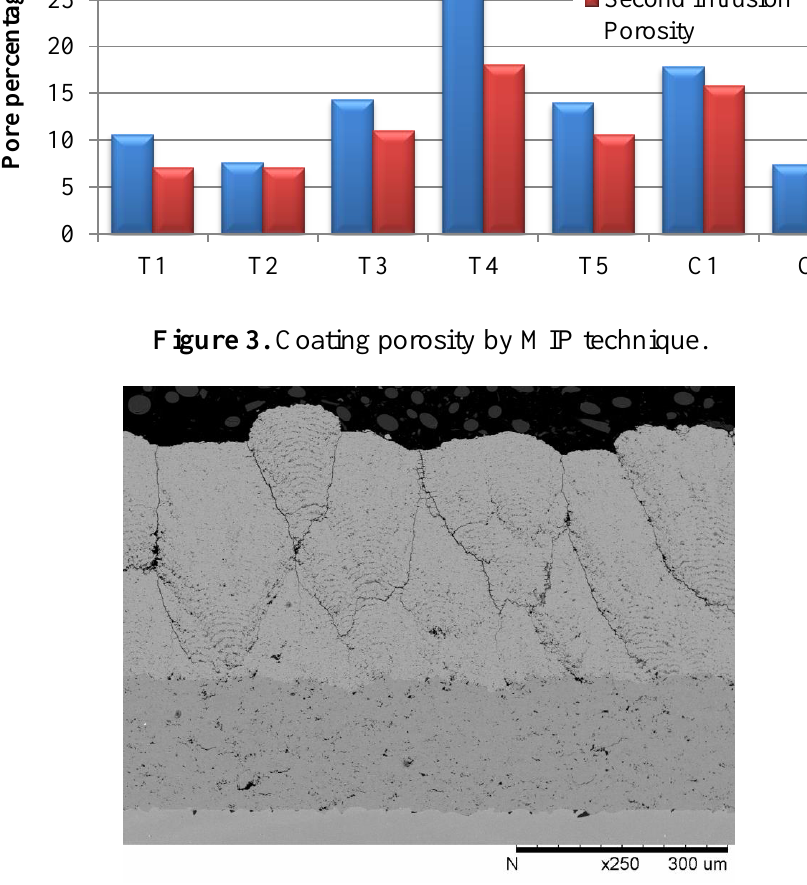
Figure 4. T1 coating,